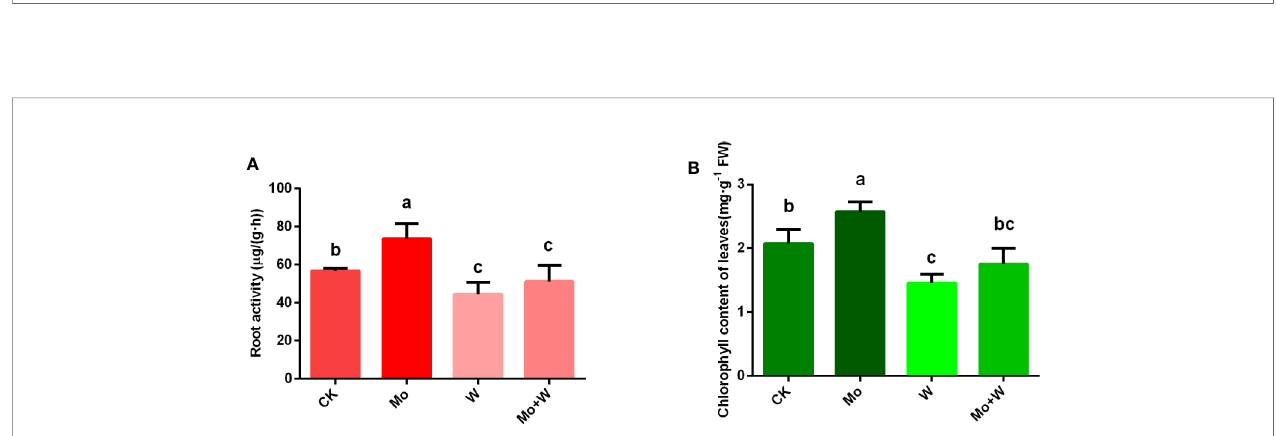
FIGURE 1 | Tissue-cultured strawberry seedlings used in this experiment. Effect of solid MS culture medium with Na2MoO4 or Na2WO4 on growth status of strawberry seedlings (A , B)